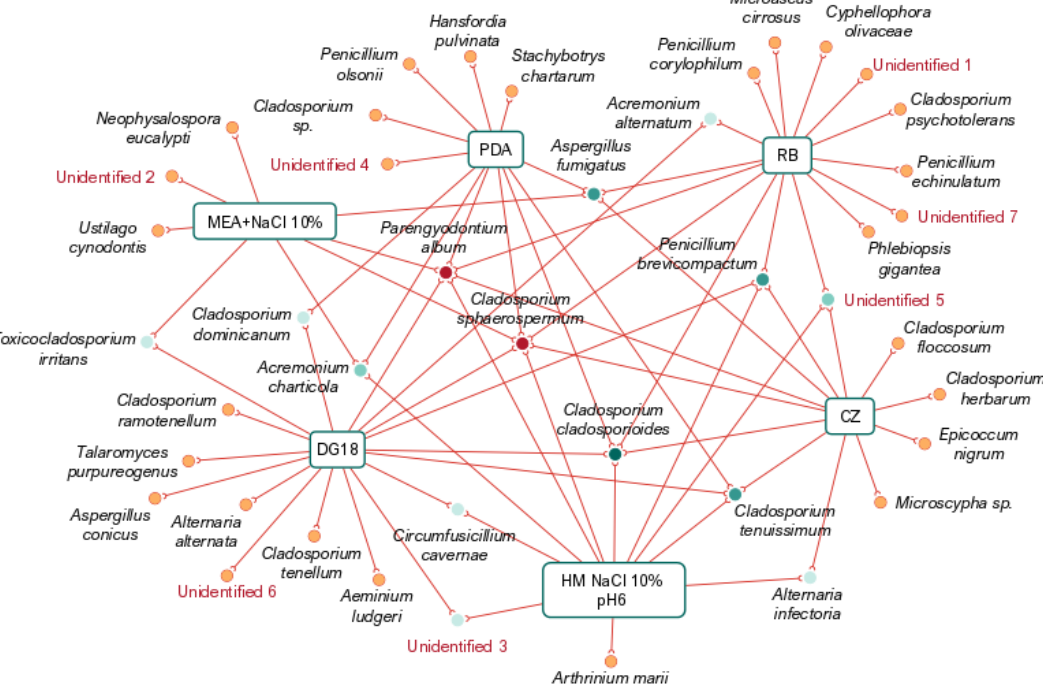
Figure 11. Co-occurrence network displaying the overlap of the cultivable species between the different culture media used for fungal isolation.